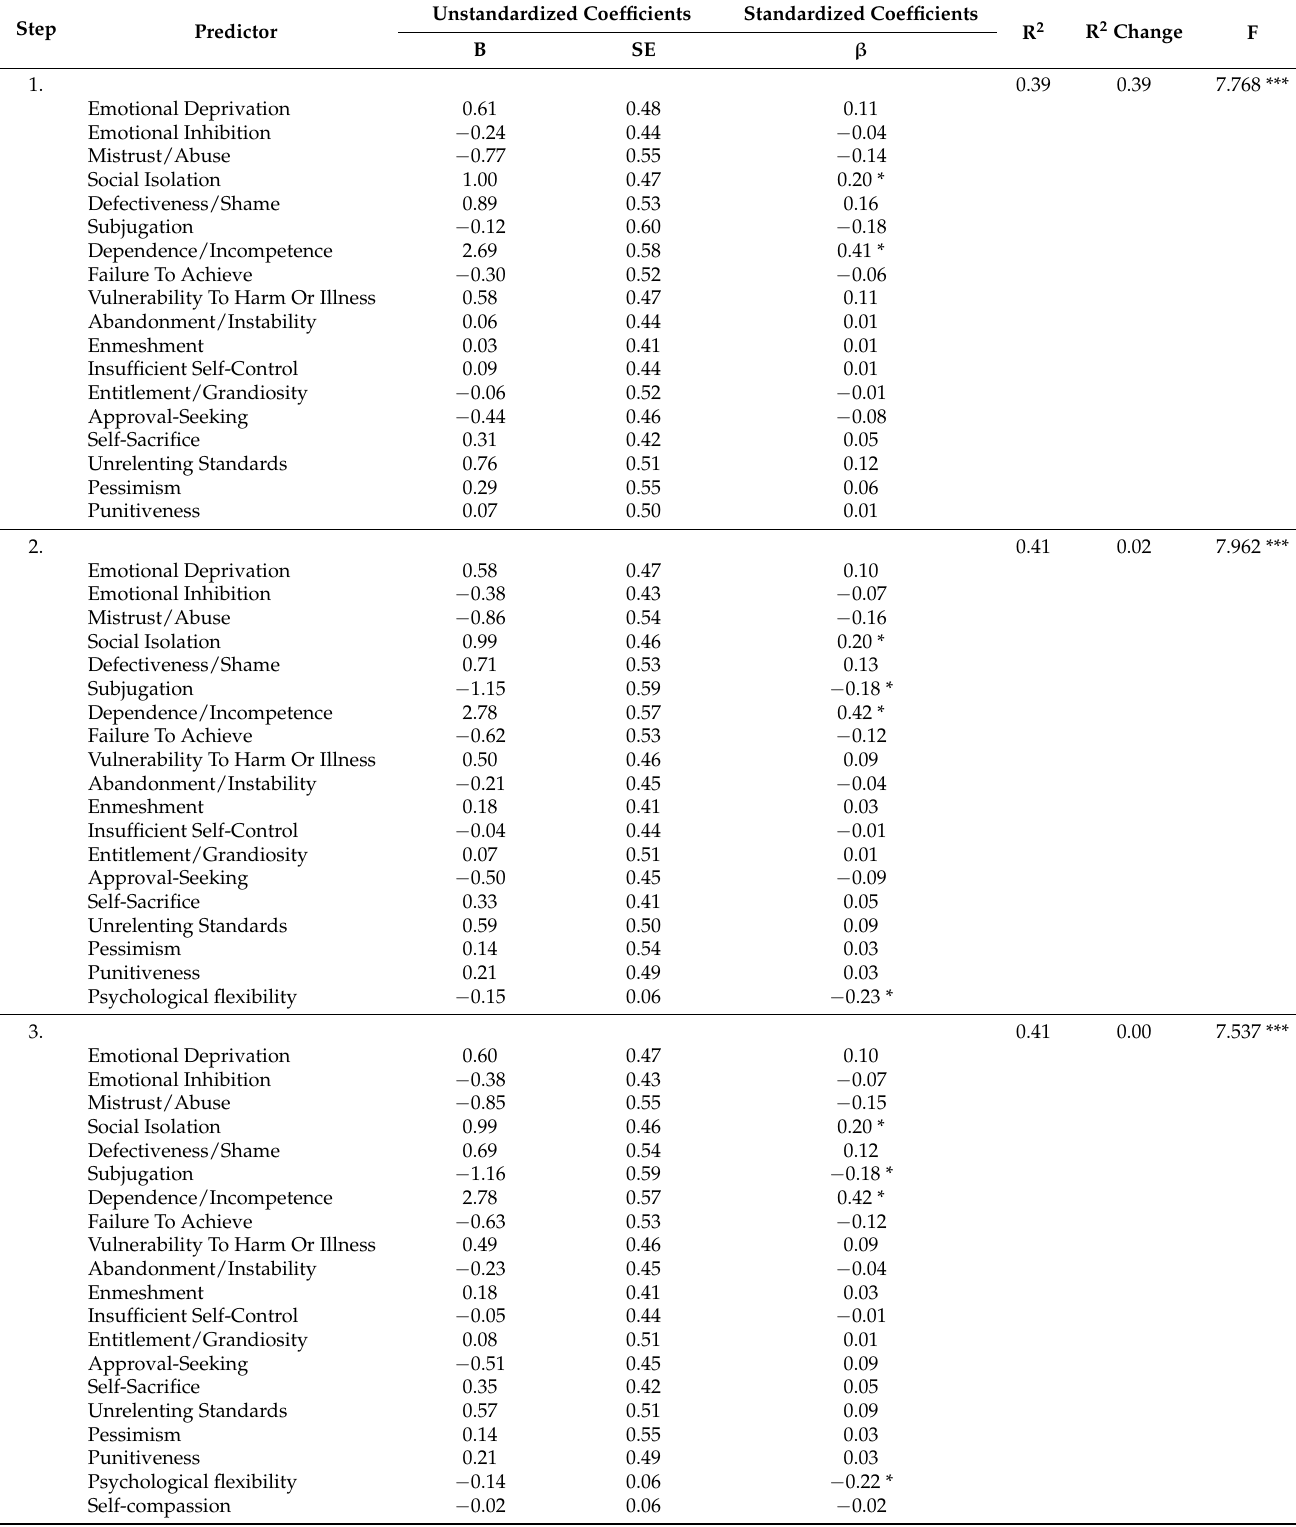
Table 3. Hierarchical regression analyses, * p < 0.05, *** p <